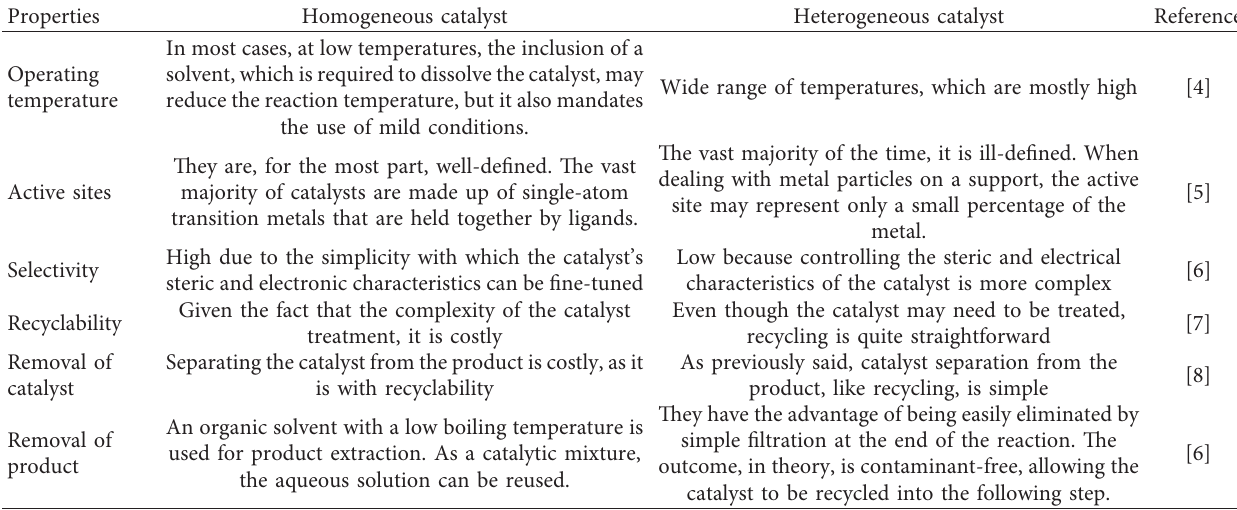
Table 1: Comparison of homogeneous and heterogeneous